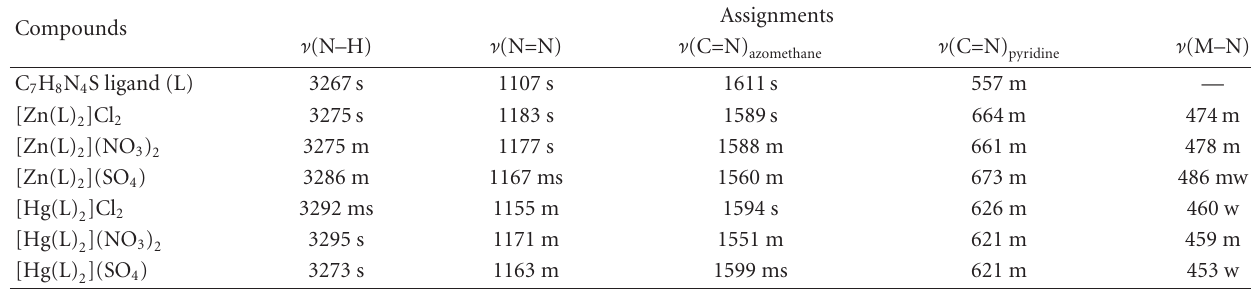
Table 2: Important infrared spectral bands (cm − 1 ) and their assignments, where s = strong; ms = medium strong; m = medium; mw = medium weak; w = weak.